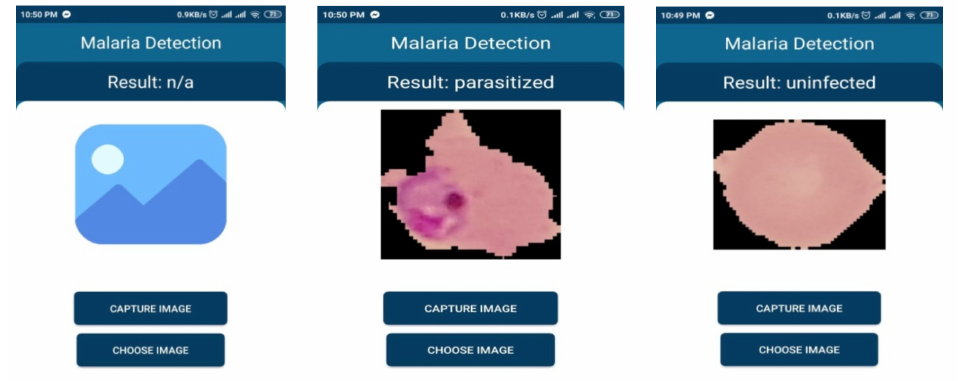
Figure 15. Model behavior on smartphone-based service.